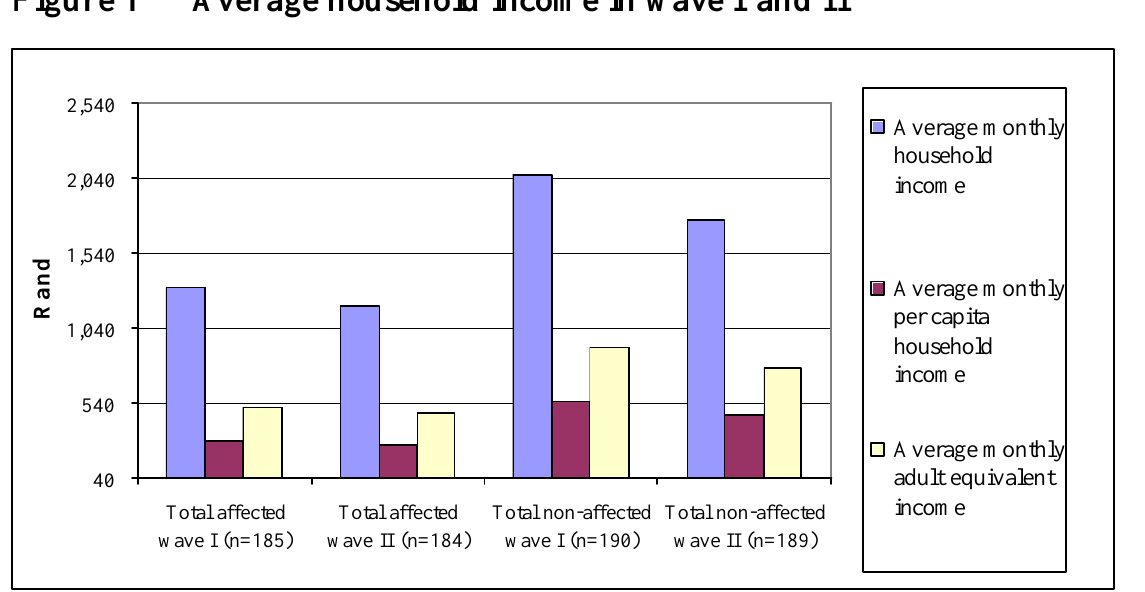
Figure 1 Average household income in wave I and